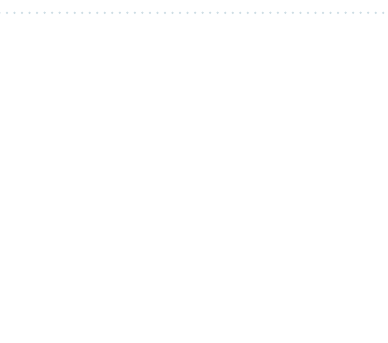
Figure 2. Boxplot comparing marginal distributions of clustered vs expert-labelled groups.